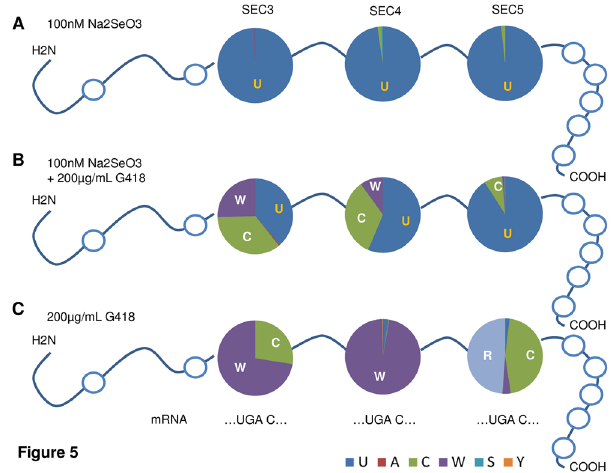
Figure 5. Amino acid insertion at UGA codons SEC3, SEC4 and SEC5 in SELENOP. HepG2 cells were treated with 100 nM Se, 200 µ g/mL G418 or their combination. SELENOP was purified by immuno-affinity and subjected to LC-MS/MS analysis. ( A ) Sec in SELENOP was detected almost exclusively at the positions SEC3, SEC4 and SEC5 when cells were supplemented with selenite. ( B ) The pattern of amino acids inserted at the three Sec codons varied strongly when cells were grown in the presence of 100 nM selenite and 200 µ g/mL G418. ( C ) SELENOP synthesized in the absence of supplemental selenite but in presence of 200 µ g/mL G418 was devoid of Sec residues at the three positions available for analysis (SEC3-5). The amino acids replacing Sec were mainly tryptophan (W), cysteine (C) and arginine (R), but their relative proportions were Sec-codon